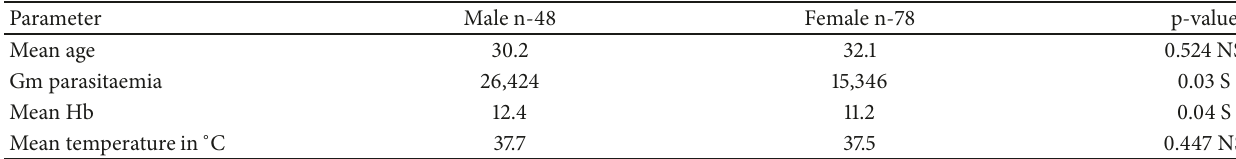
Table 2: Geometrical means of age, parasite density, temperature, and Hb between gender day 0.